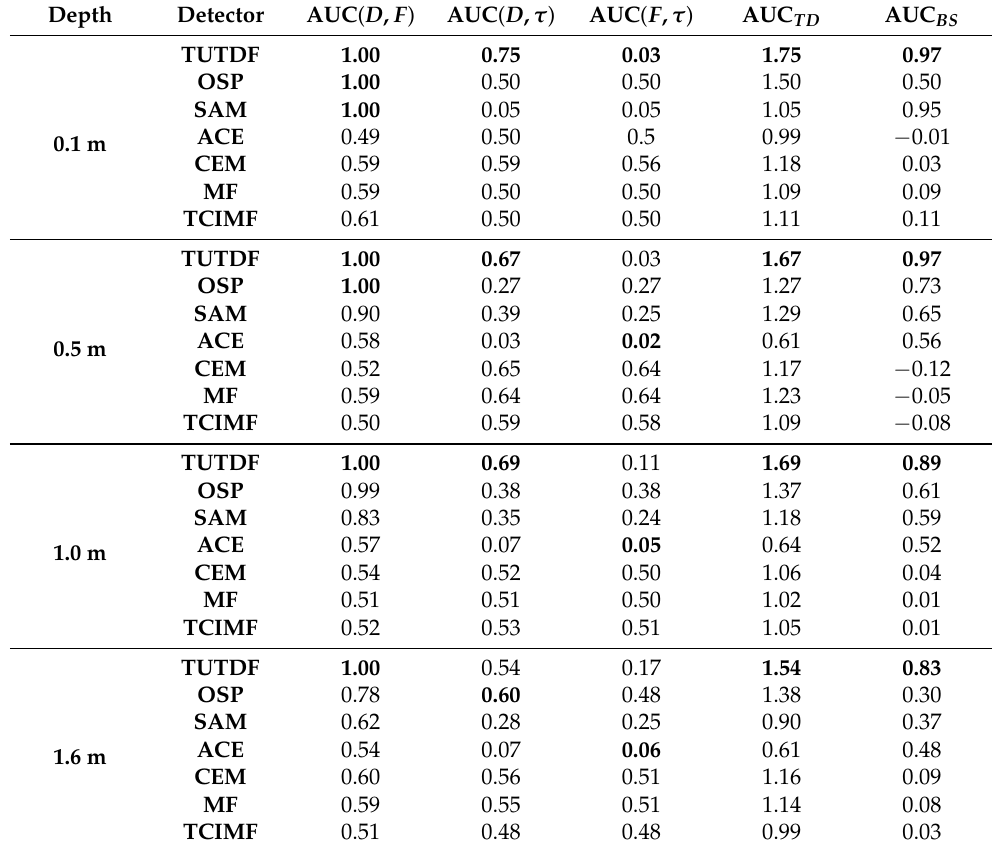
Table 4. AUC values calculated from the three 2D ROC curves of different detection results on iron at various